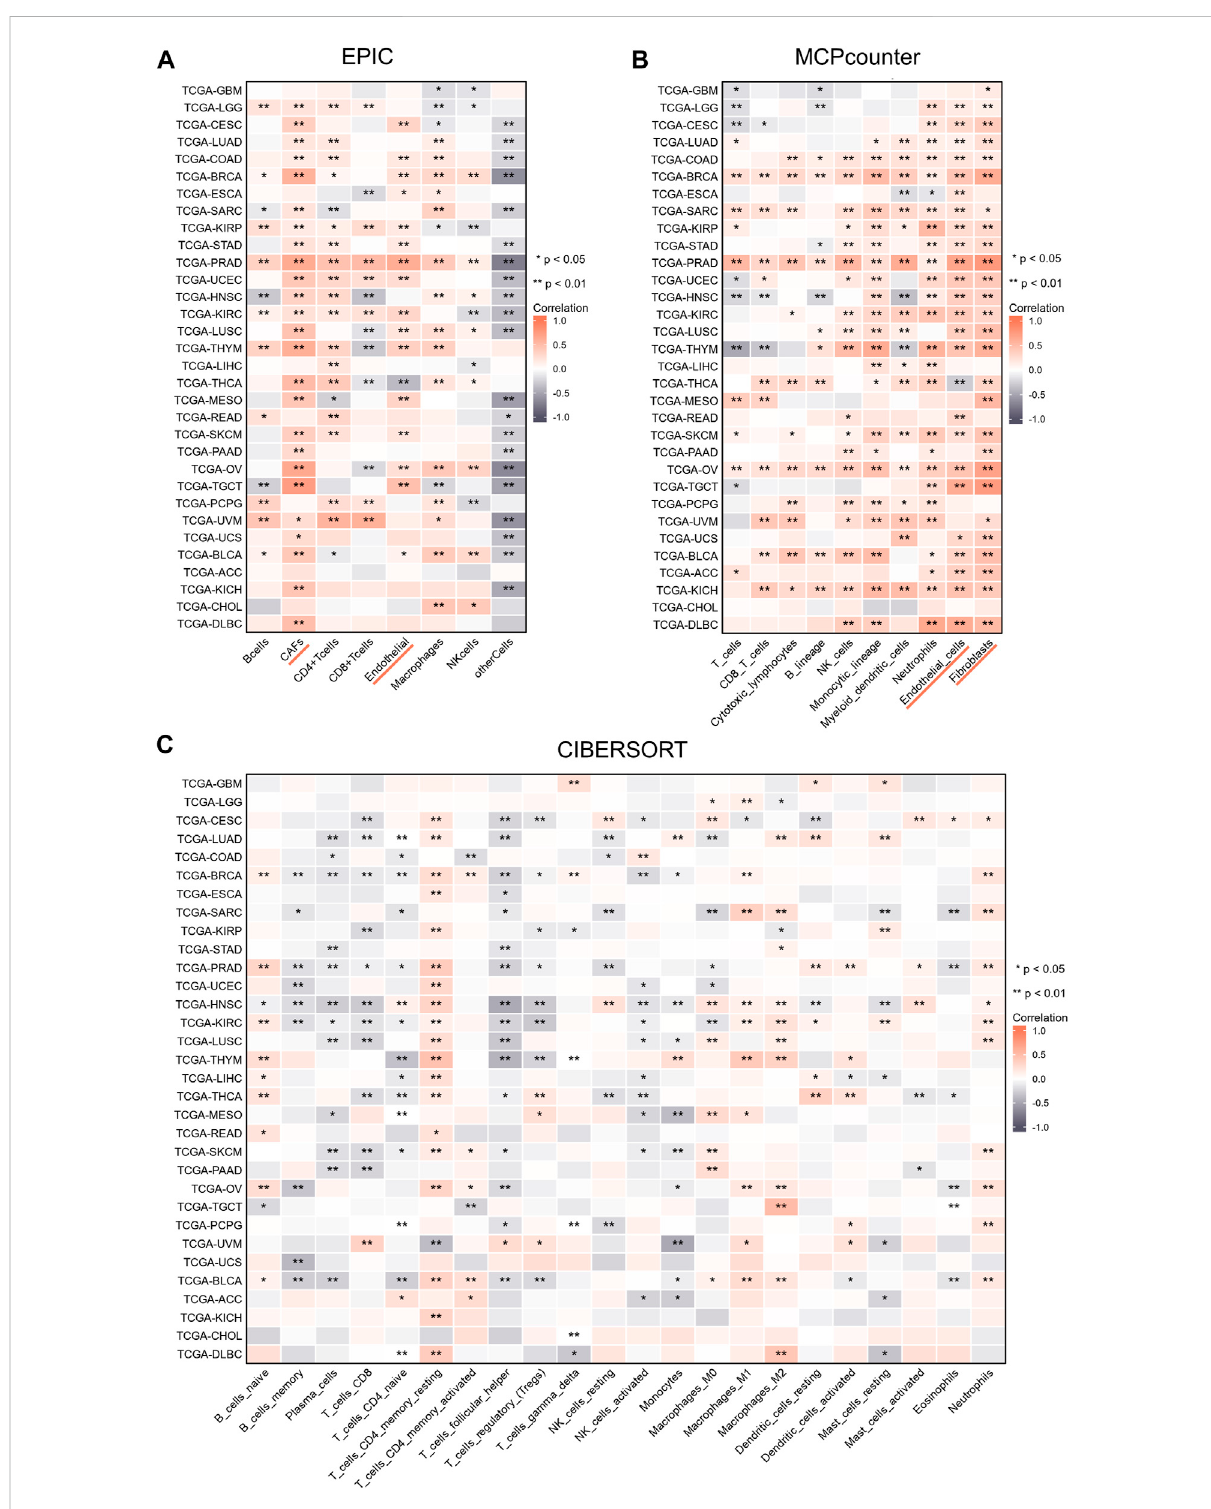
FIGURE 3 (A – C) The relationships of NT5E expression and the in fi ltration levels of immune cells in cancers based on EPIC (A) , MCPcounter (B) , and CIBERSORT methods (C) . Positive correlation in red and negative correlation in gray. (* p < 0.05; ** p <